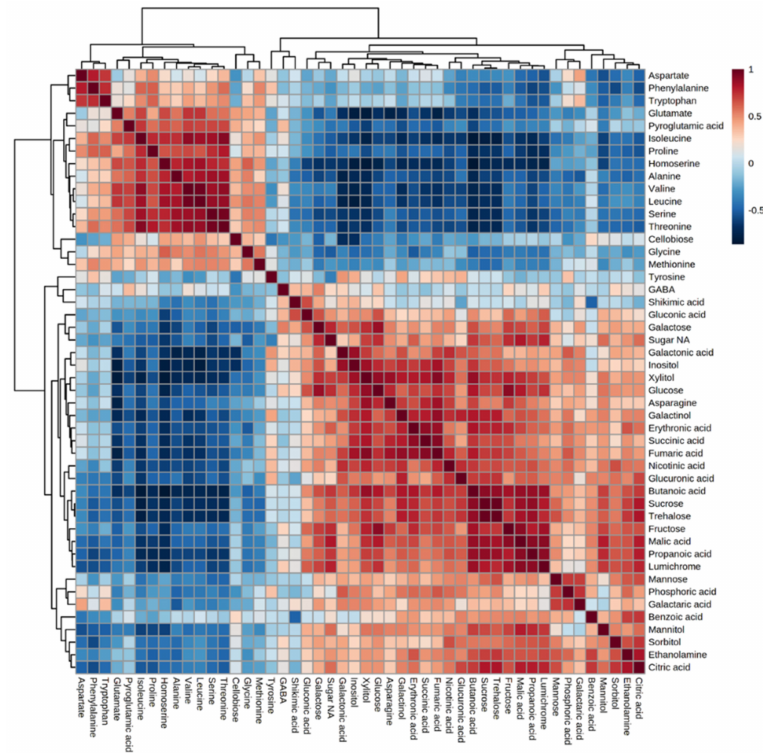
Figure 4. Correlation matrix among the 58 metabolites detected in the parasites that developed on the 10 different hosts using Pearson correlation coefficients. Each data point is the average of four biological replicates. Dendrograms are shown on the top and left of the correlation matrix, indicating the clustering of positive and negative correlations. Red and blue colors indicate positive and negative correlations,